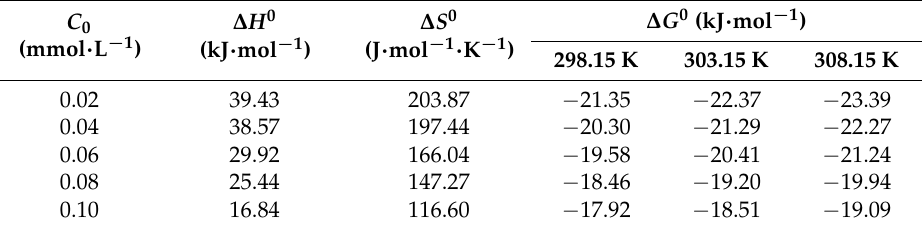
Table 2. Thermodynamic parameters for adsorption of Cd(II) on the imprinted biochar.